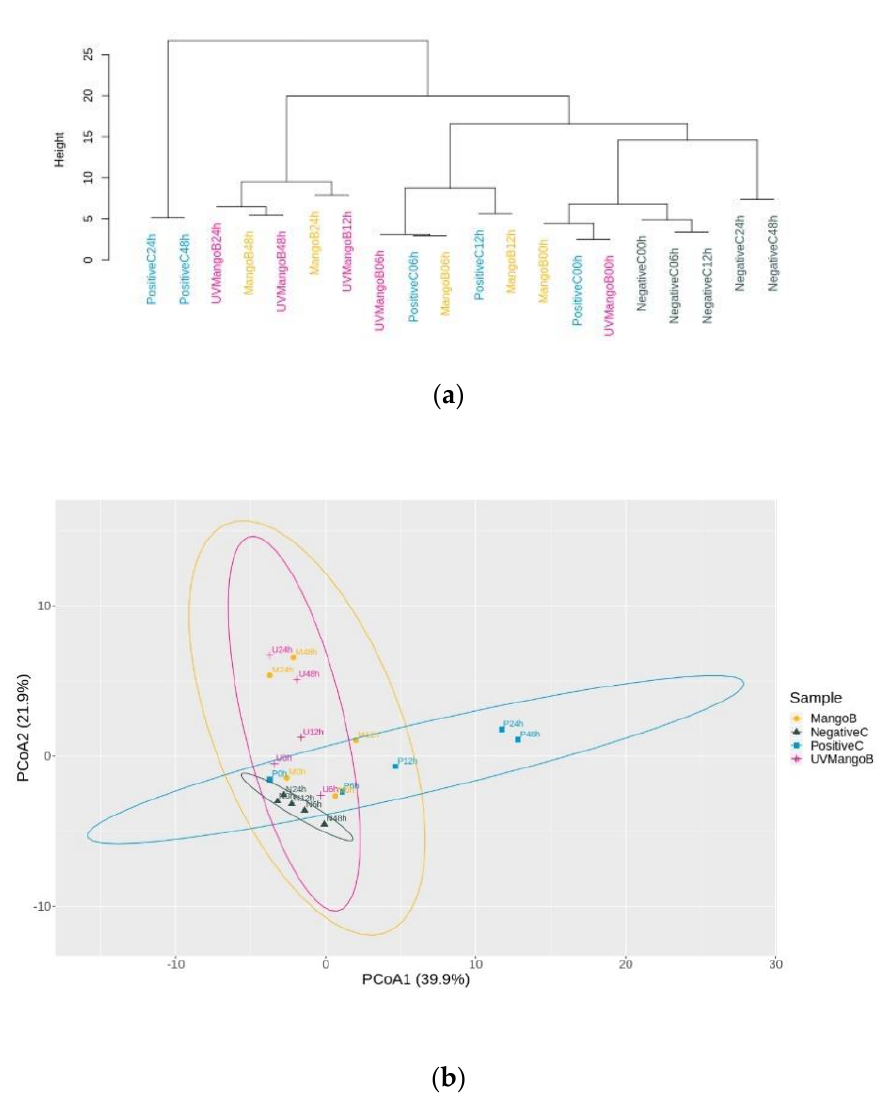
Figure 3. Clustering and principal coordinate analysis (PCoA) of observed species into amplicon sequences variants (ASVs) from in vitro colonic fermentation samples at 0, 6, 12, 24 and 48 h of negative control (NegativeC), positive control (PositiveC), UV-C irradiated mango bar (UVMangoB) and non-irradiated mango bar (MangoB) treatments. ( a ) Hierarchical clustering dendrogram based on the Euclidean distance of genera abundance higher that 0.05%. ( b ). First two eigenvalues (PCoA1 and PCoA2) based on the Euclidean distance matrix of ASVs found during 48 h of colonic fermentation. The PCoA (Figure 3b) revealed that the two eigenvalues (PCoA1 with 39.9% and PCoA2 with 21.9%) reflected the variance represented by the contributory factors for the microbial composition of four treatments and five times. This analysis separated the PositiveC treatment towards PCoA1, while PCoA2 put together colonic fermentation samples of MangoB and UVMangoB, according to a similar abundance of microbial composition. Most samples from PositiveC were separated from NegativeC and MangoB in at least two of the coordinate combinations. The permutational multivariate analysis of variance (PERMANOVA) analysis confirmed that the major significant di ff erences were obtained due to treatment samples ( F = 2.769, R 2 = 0.273, p = 0.001), as compared to the fermentation time ( F = 3.718, R 2 = 0.122, p = 0.002). A considerable significance was obtained for the sample–time interaction ( F = 2.141, R 2 = 0.211, p =